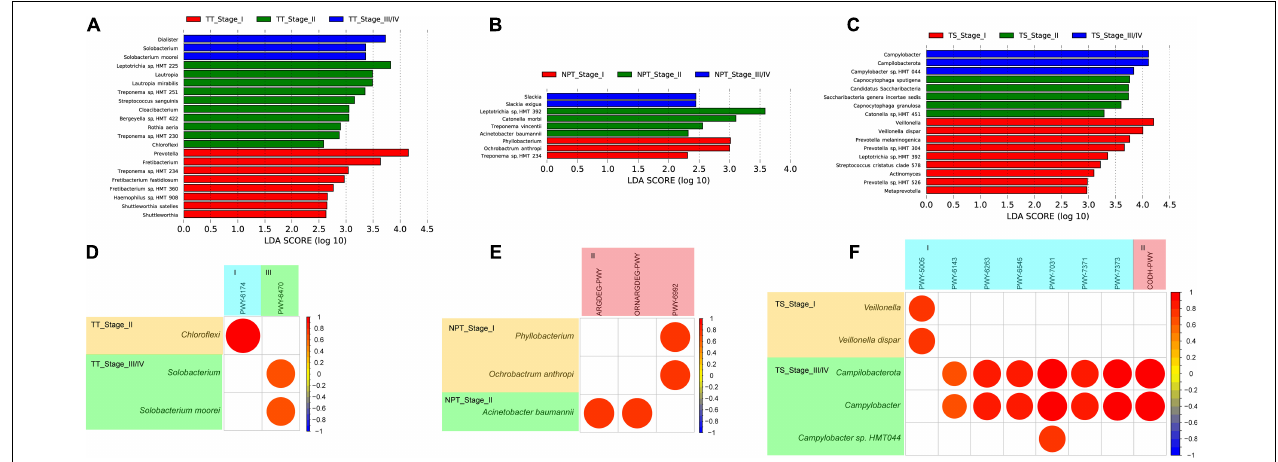
FIGURE 7 | LDA scores computed for differentially abundant taxa among different clinical stages of TT (A) , NPT (B) , and TS (C) samples, and correlation coefficient among different species and minipaths in different clinical stages of TT (D) , NPT (E) , and TS (F) samples. I, biosynthesis; II, degradation/utilization/assimilation; III, generation of precursor metabolites and